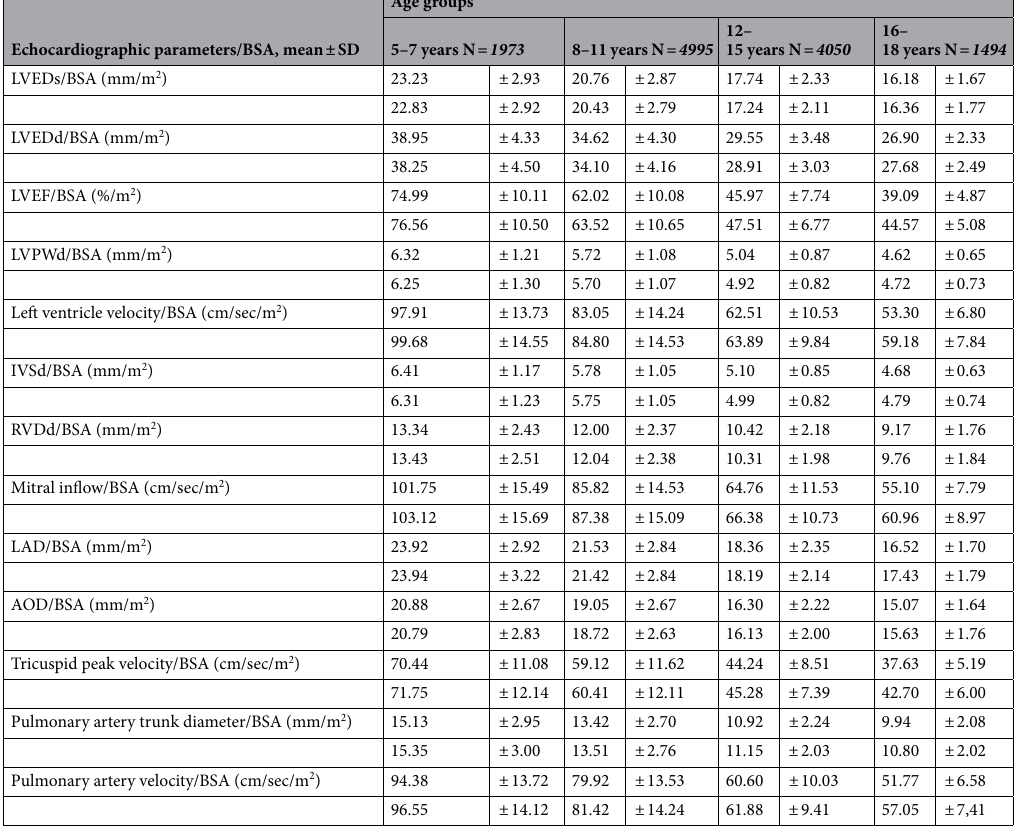
Table 5. Echocardiographic parameters indexed on BSA according to age and gender (males, upper row and females, lower row). BSA, body surface area ; SD, standard deviation. LVEDs , left ventricular diameter at end-systole; LVEDd , left ventricular diameter at end-diastole; LVEF , left ventricle ejection fraction; LVPWd , left ventricular posterior wall thickness at end-diastole; IVSd , interventricular septum thickness at end-diastole; RVDd , right ventricular diameter at end-diastole; LAD , left atrial diameter; AOD , aortic